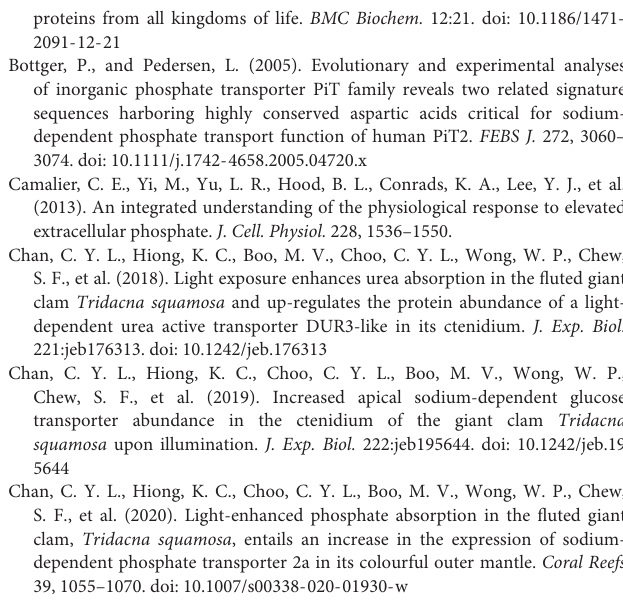
Supplementary Figure 1 | Peptide competition assay (PCA) on anti-PiT1-like antibody. The presence of PiT1-like band of a kidney sample exposed to light for 12 h (A) disappeared when anti-PiT1-like antibody was neutralized with the immunizing peptide (B) . L,